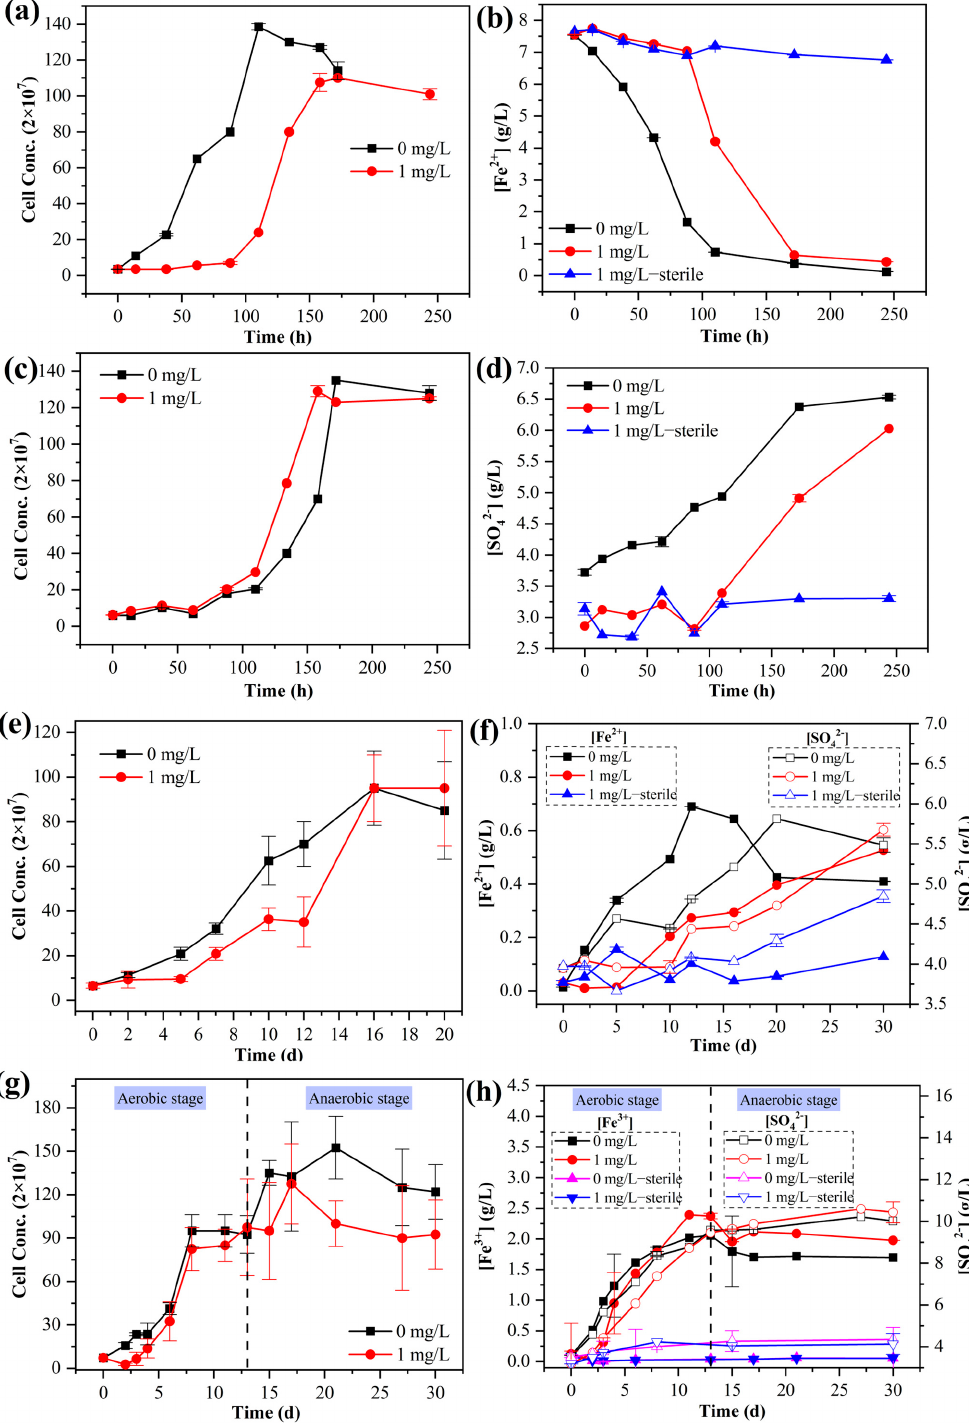
Figure 1. Bacterial growth and Fe/S oxidation for the groups of A. ferrooxidans ATCC 23270 grown with Fe 2+ ( a , b ), S 0 ( c , d ), anaerobic Fe 3+ reduction coupled with S 0 oxidation ( e , f ), and aerobic– anaerobic coupling ( g , h ) with and without the addition of 1 mg/L Hg 2+ . 3.2. Changes in pH and [Hg 2+ ] in Aqueous Solution For the group with Fe 2+ oxidation by A. ferrooxidans ATCC 23270 under aerobic con- ditions (Figures 2a and S2d), the overall pH value increased initially and then decreased. Compared with the bio group without Hg 2+ , the pH value of the bacterial experimental group with 1 mg/L [Hg 2+ ] increased and decreased slowly, and the lowest pH value (1.76) was relatively high. [Hg 2+ ] in the solution for the bio group with Hg 2+ showed an overall downward trend, and [Hg 2+ ] fl uctuated with time during 0–88 h and rapidly decreased after 88 h (Figure 2b). This may have been because A. ferrooxidans ATCC 23270 can reduce the total Hg concentration by reducing Hg 2+ to Hg 0 . In addition, the formation of ferrosite substances also has a certain adsorption e ff ect on Hg [24]. In contrast, there was no sig- ni fi cant change in [Hg 2+ ] for the sterile control group. For the groups with S 0 oxidation by A. ferrooxidans ATCC 23270 under aerobic con- ditions (Figures 2c and S2e), the pH value of the solution showed a decreasing trend with time within 0–244 h. There was no obvious change in pH value for the bacterial group within 0–88 h. The overall pH value decreased slowly and fi nally reached the lowest pH value (244 h). A. ferrooxidans uses S 0 as the energy substrate for oxidation, which is an acid-producing process, resulting in a decrease in solution pH value. However, Hg 2+ can obviously inhibit the process, resulting in a slower pH decline in the group with Hg 2+ . There was no signi fi cant change in the sterile control group [Hg 2+ ] (Figure 2d). For the bacterial group with [Hg 2+ ], the e ff ect of mercury stress was the weakest when the con- centration of Hg 2+ reached 0.83 mg/L. Hg 2+ in the solution reacts with SO 42 − to form HgSO 4 , which can also be complexed with S 0 and adsorbed to the surface of S 0 particles